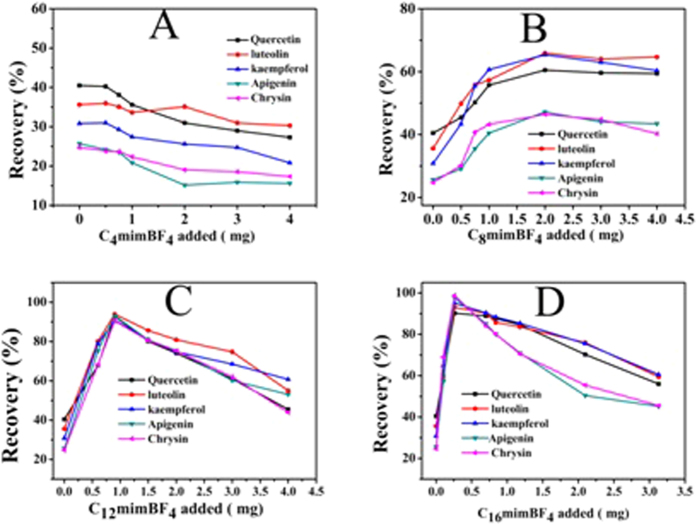
Effect of different lengths of carbon chain ionic liquid on the adsorption of five flavonoids: (A) C4mimBF4, (B) C8mimBF4, (C) C12mimBF4 and (D) C16mimBF4.